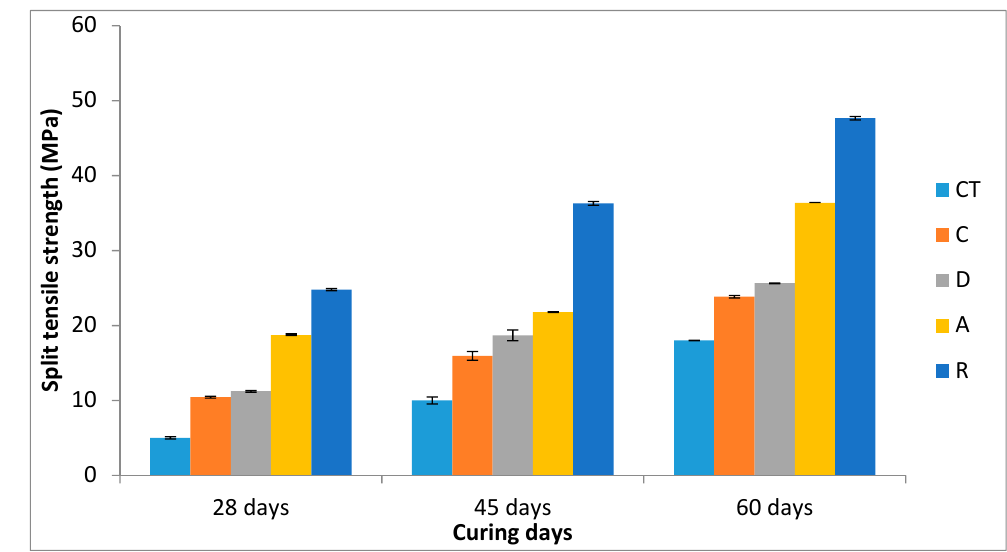
Figure 4. Split tensile strength result. (Legend: CT = control, C = 10% latex, D = 0.5% fiber and 10% latex, A = 1% fiber and 10% latex and R = 1.5% fiber and 10% latex.)